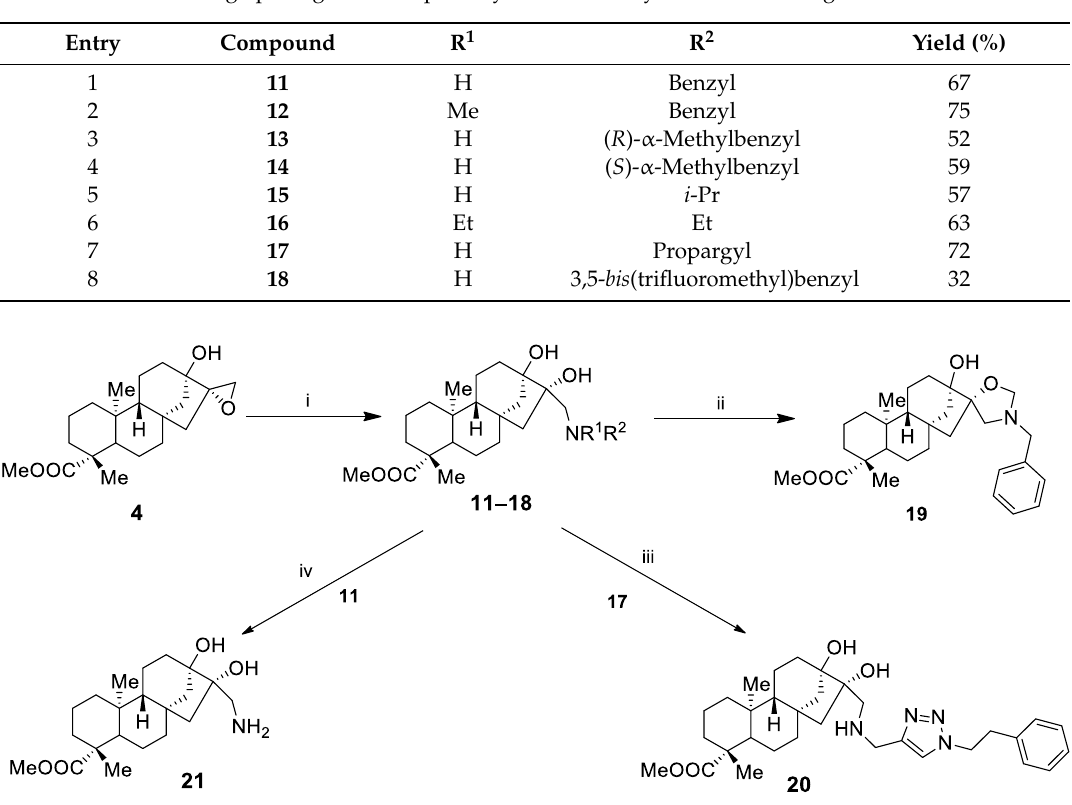
Table 1. Ring opening of 4 with primary and secondary amines according to Scheme 4.